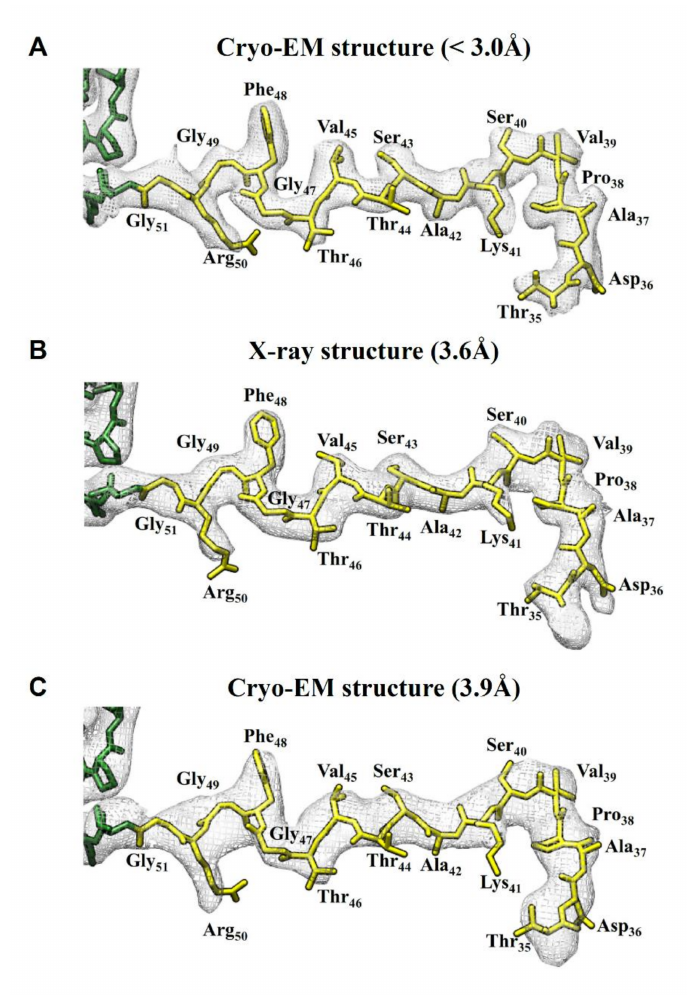
Figure 4. Comparison of the density maps of the N-terminal domain (NTD). From top to bottom are ( A ) the cryo-EM structure of DGNNV (<3.0 Å), ( B ) the X-ray structure of RGNNV (3.6 Å) (prepared from PDB:4WIZ) [33], and ( C ) the cryo-EM structure of OSGNNV (3.9 Å) (prepared from EMDB-6453 and PDB:3JBM) [43]. They are presented from top to bottom in descending order of resolution. The density maps are displayed by gray mesh. The model of the capsid protein in colored in green, while that of the NTD is highlighted in